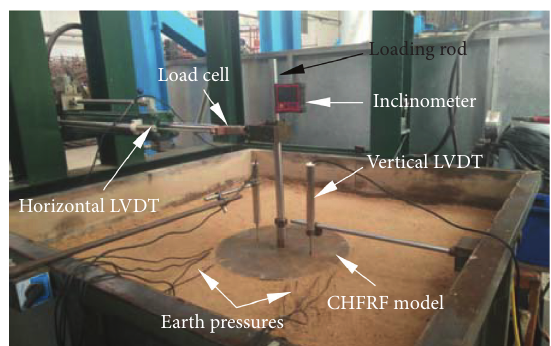
Figure 3: Model test setup.